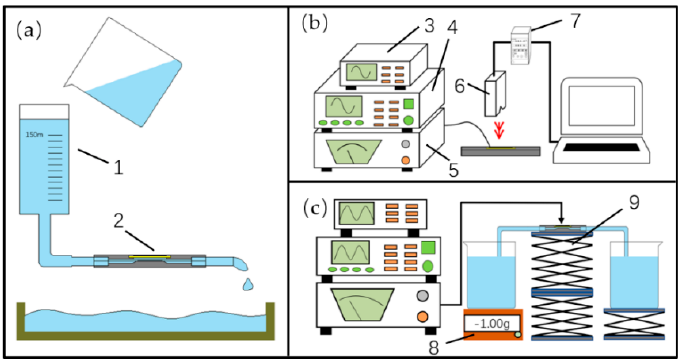
Figure 4. Experimental setups: ( a ) the experiment of flow-resistance difference; ( b ) the amplitude measurement of the PZT vibrator; ( c ) the flow rate measurement; (1) syringe barrel; (2) the PZT pump; (3) oscilloscope; (4) signal generator; (5) power amplifier; (6) laser sensor; (7) the controller; (8) electronic balance; (9) lifting platform.